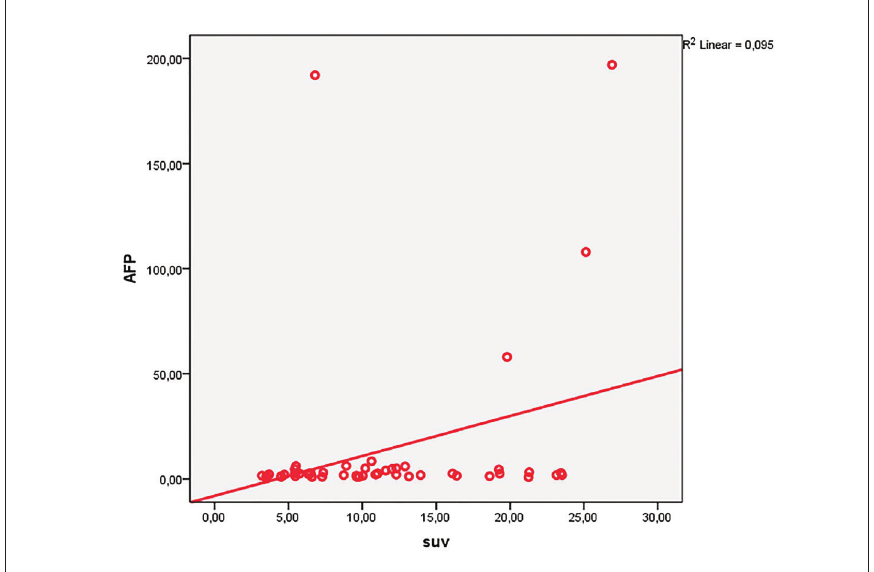
Figure 3. Linear correlation of the relationship between serum AFP levels in 50 patients with gastric cancer forming the study group and SUVmax readings of the primary